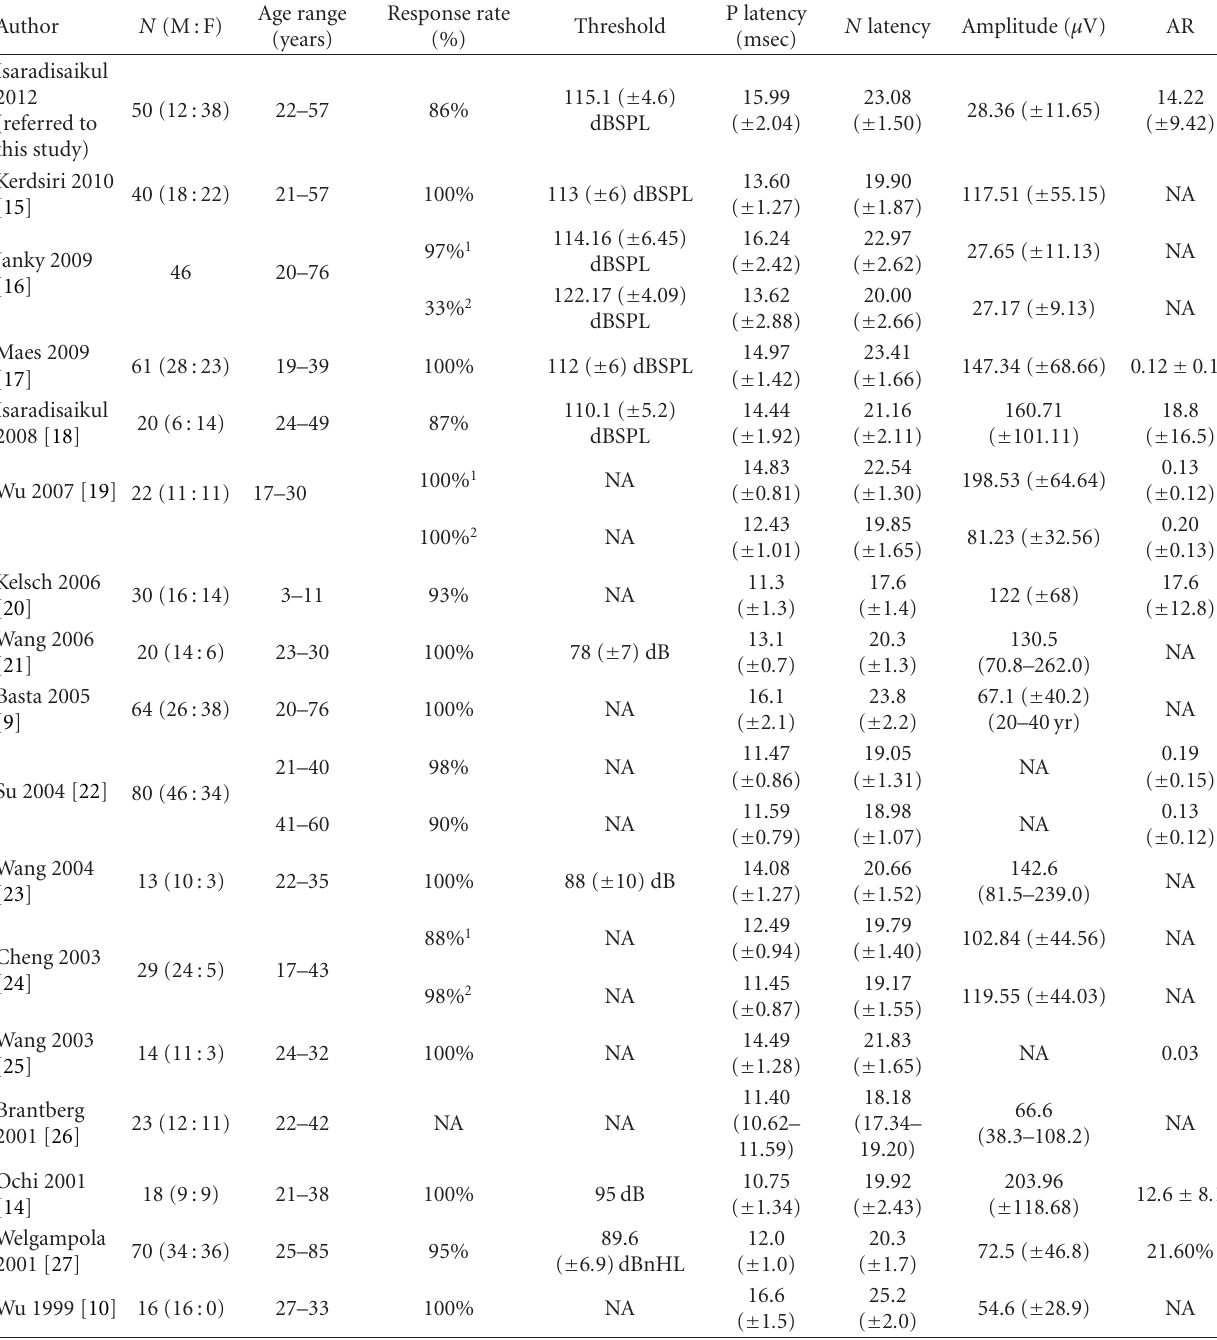
Table 4: Normative values of VEMP (mean ± SD) from